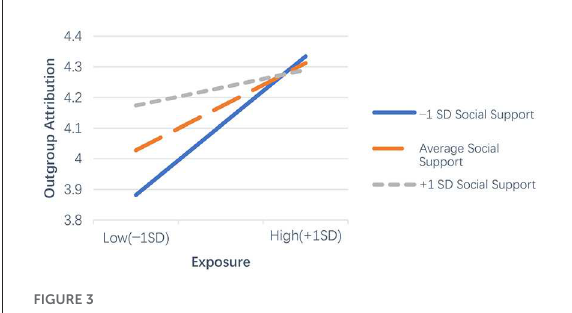
FIGURE3 Graphical representation for moderating effect of social support on the relationship between exposure and outgroup attribution.